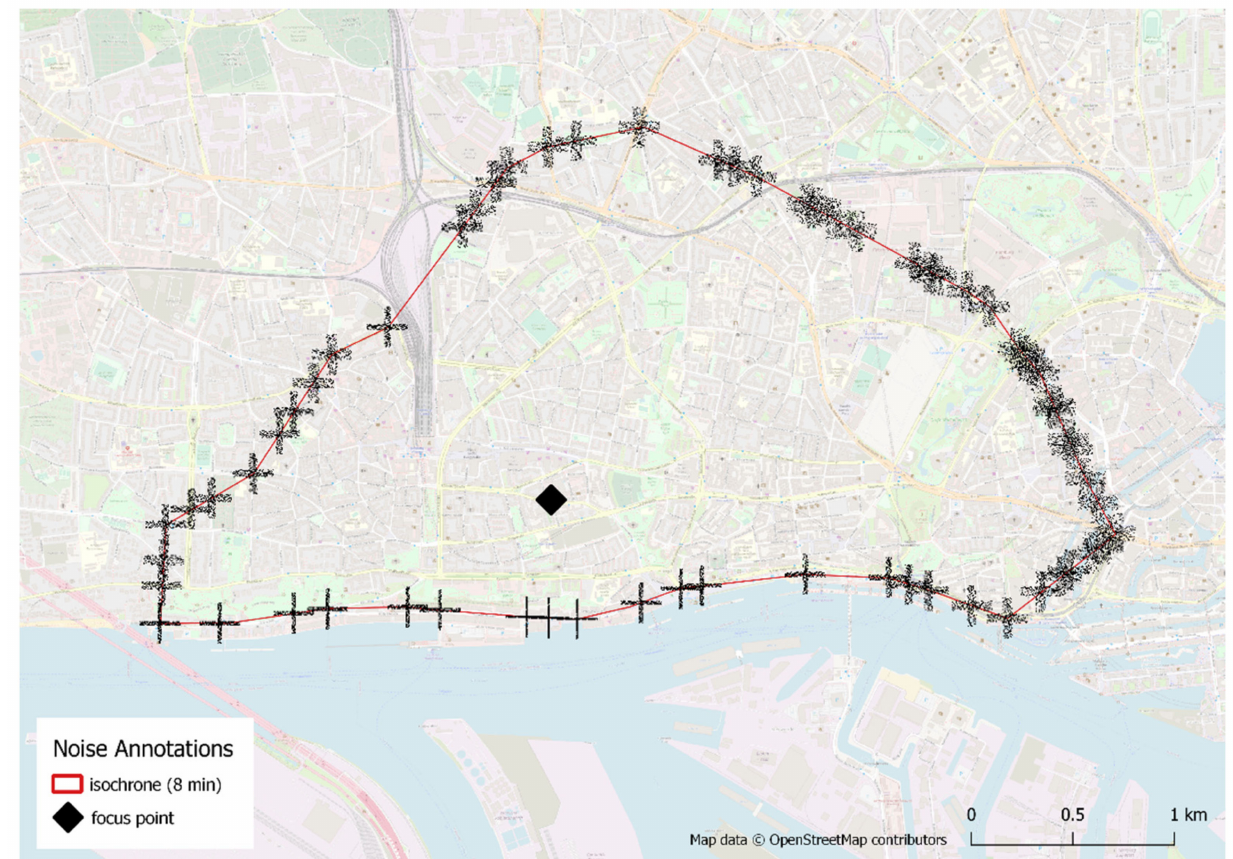
Figure 9. Example 5: Time variance due to red traffic lights, expressed by noise annotation crosses (noisier appearance stands for larger number of traffic lights on the shortest